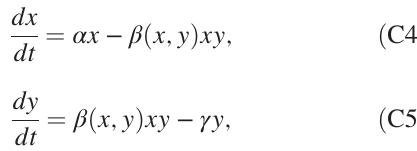
FIG. 9. Variation of steady-state monomer concentration with k for (a) N ¼ 300 and (b) N ¼ 1000 . κ 0 ¼ 1 , and κ D were used for all plots. Φ 0 values for the LCDR cases are shown in the legend. k 0 ¼ 1 is used for the LMA